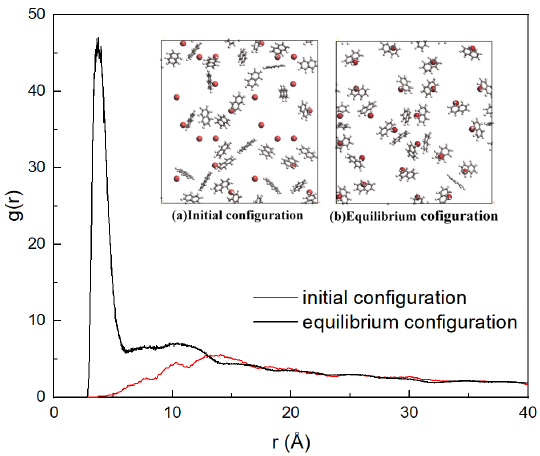
Figure 3. The interaction energies between montmorillonite and kaolinite surfaces and the naphtha- lene molecules in relation to the change in simulation time.